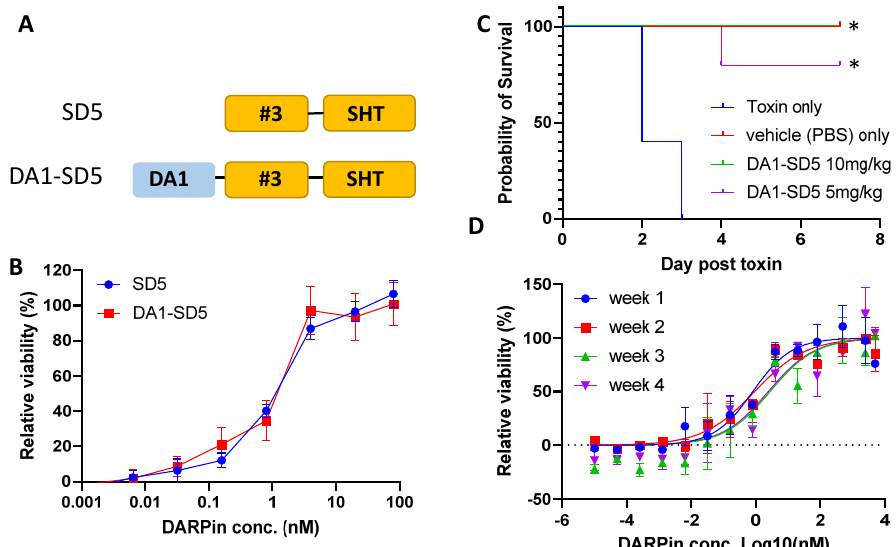
Figure 7. Evaluation of the in vivo activity. ( A ) Schematic of DARPin DA1-SD5 in comparison to SD5. ( B ) DARPin DA1-SD5 retains similar toxin-neutralization potency as SD5, as determined by Vero E6 cell viability assay. ( C ) DARPin DA1-SD5 protected mice from Stx2a toxicity ( n = 5); Mantel–Cox test, * p < 0.002. ( D ) Toxin neutralization activity of DA1-SD5 after storage at room temperature for 1–4 weeks, as determined by Vero E6 cell viability assay.